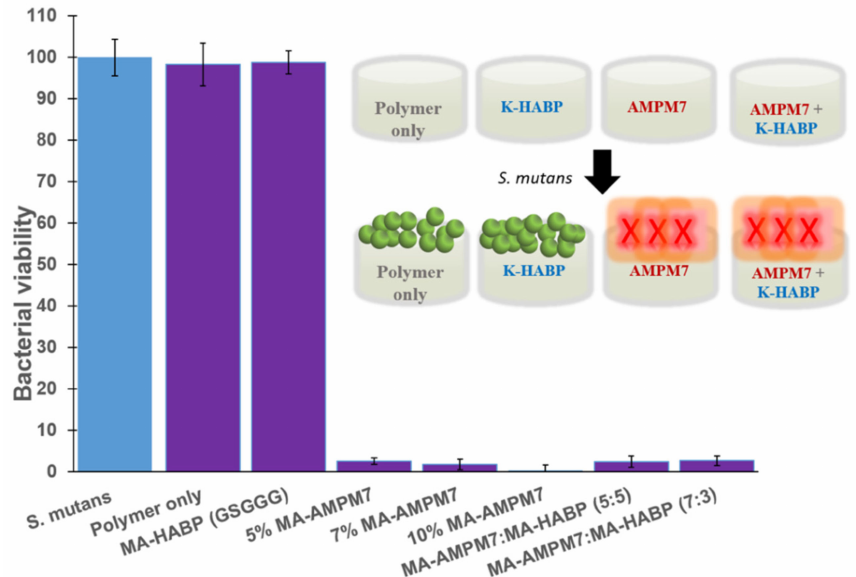
Figure 6. Schematic illustration and graphical representation of the viability of S. mutans cultures after overnight incubation with polymerized discs containing peptide samples. S. mutans : a positive control without a